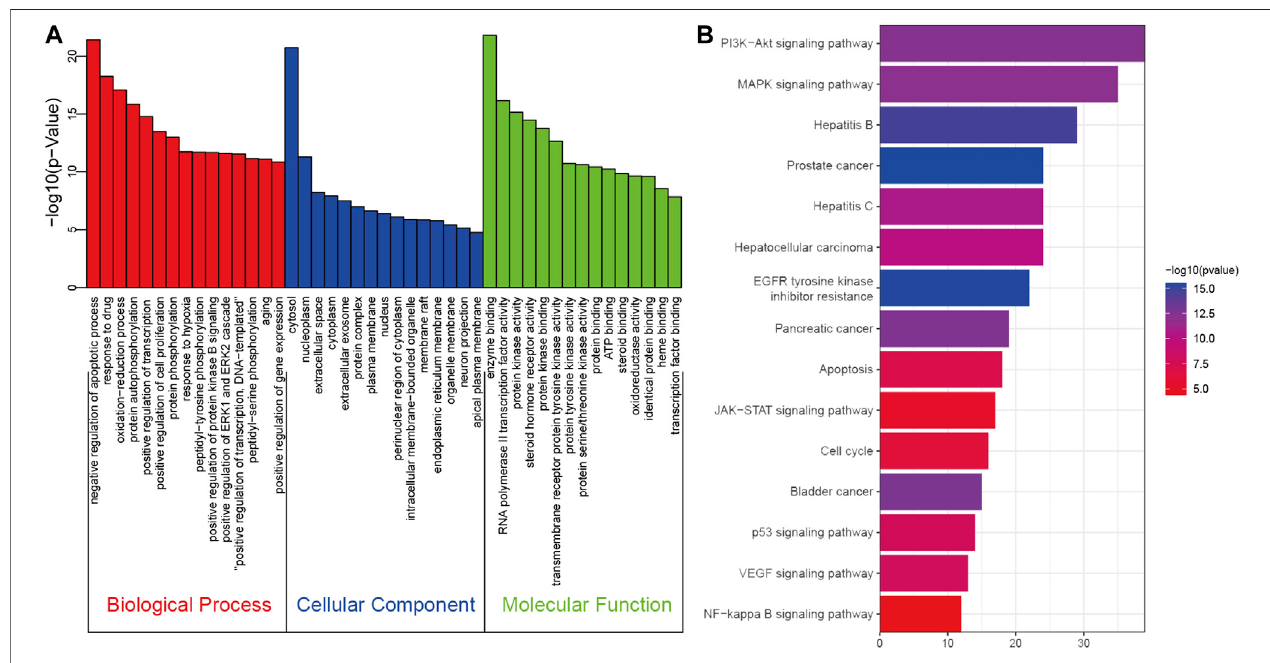
FIGURE 5 | The GO (A) and KEGG pathway enrichment (B) analysis of 258 therapeutic genes of SO on HCC.